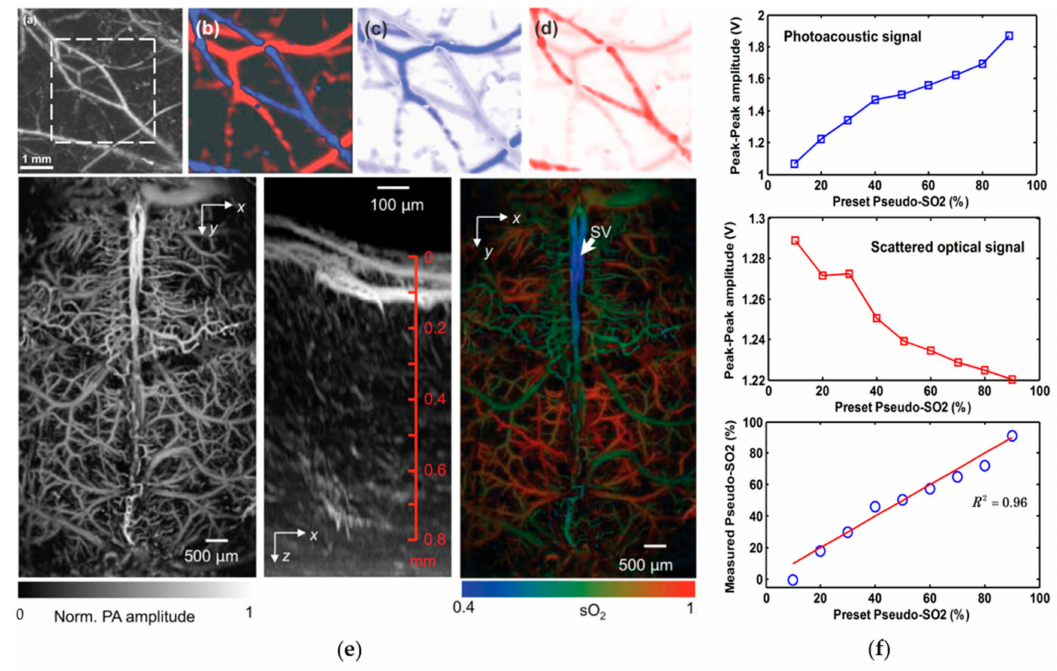
Figure 7. ( a ) PA microscopic imaging, ( b ) static SO 2 image, ( c ) differential SO 2 image (from hypoxia to normoxia), and ( d ) differential SO 2 image (from normoxia to hypoxia) of subcutaneous blood vessels in a rat; ( e ) SO 2 images of the mouse brain obtained by PA spectroscopic technique; ( f ) PA signal, scattered optical signal, and the measured SO 2 level along with pseudo-SO 2 change. Reprinted with permission from